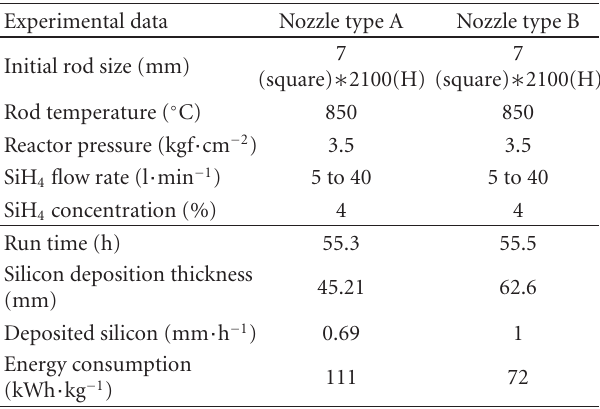
Table 1: Experimental conditions and results. Experimental